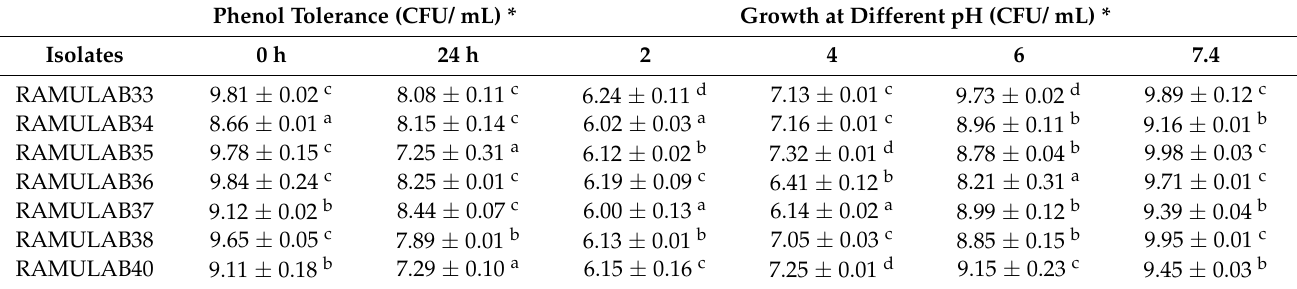
Table 2. Fermented sugarcane juice isolates phenol tolerance and growth at different pH expressed in